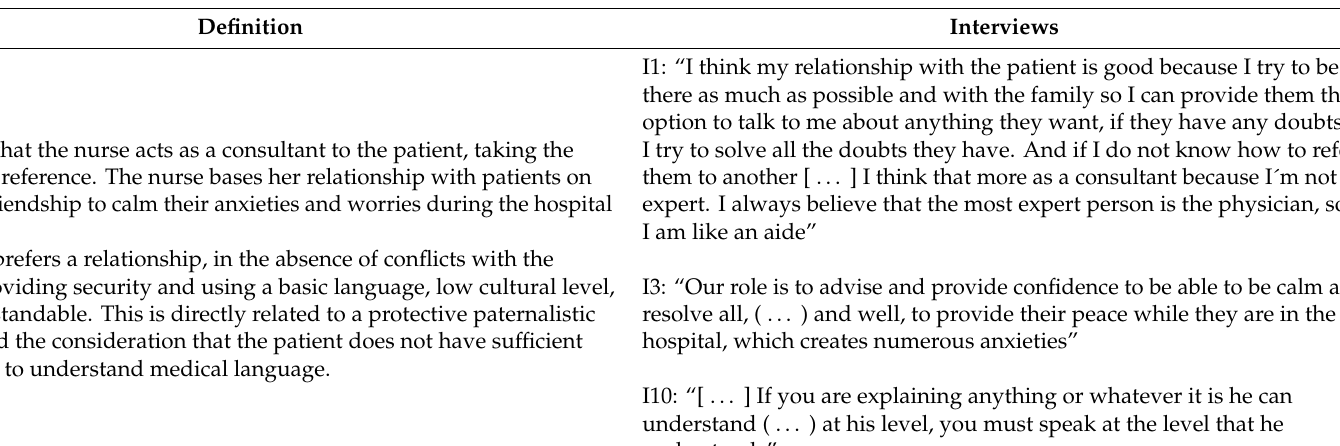
Table 5. Category, codes, and definitions in interviews about patient-nurse relationship. Category: Patient as a Passive Object of